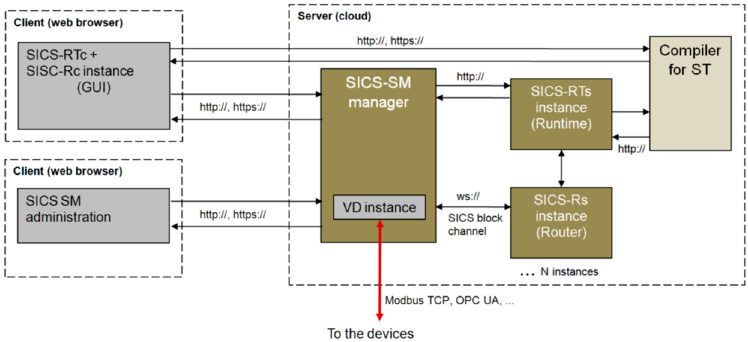
Figure 12. Implementation structure of a SICS SM controller at runtime (s—server-based part; c—client-based part).